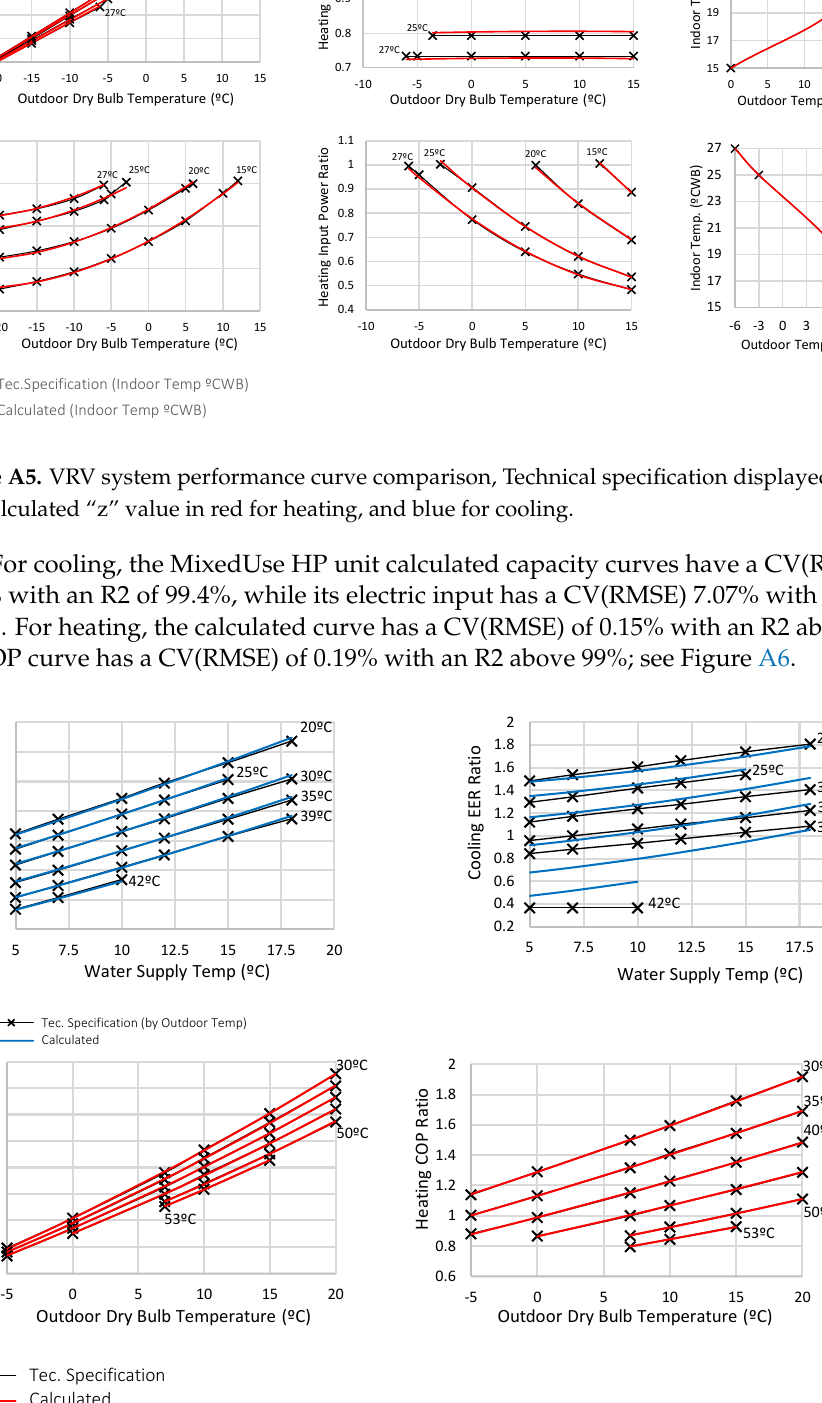
Figure A6. Heat pump performance curve comparison, technical specification displayed in black and calculated “z” value in red for heating, and blue for